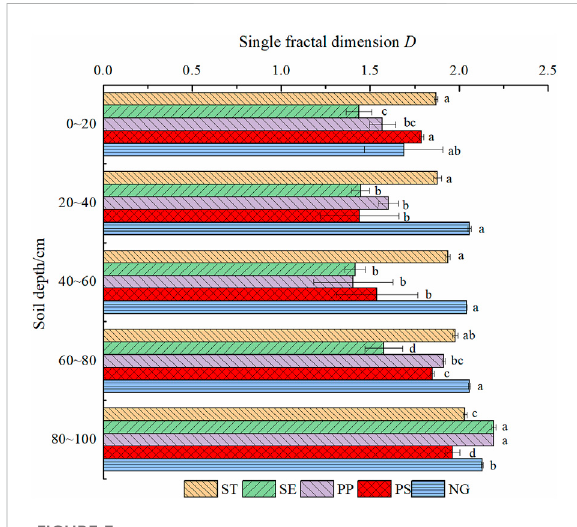
FIGURE 3 Single fractal dimension of different soil layers under Salix psammophila -3a(ST), Salixpsammophila -8a(SE), Populuspopular (PP), Pinus sylvestris var. mongolica (PS), and natural grassland